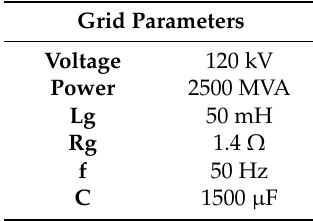
Table 1. Ratings of considered three phase